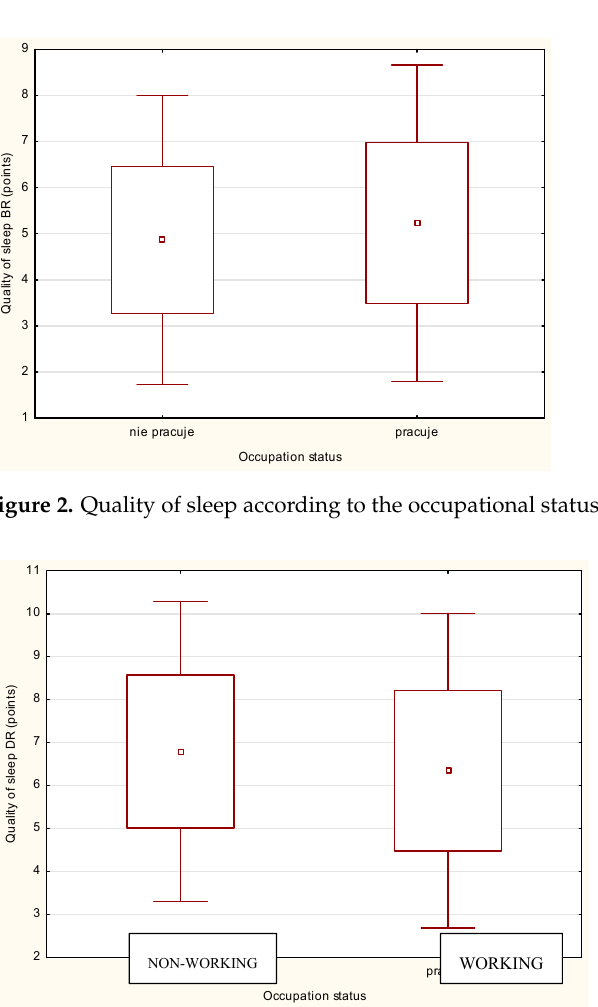
Figure 3. Quality of sleep according to the occupational status DR.